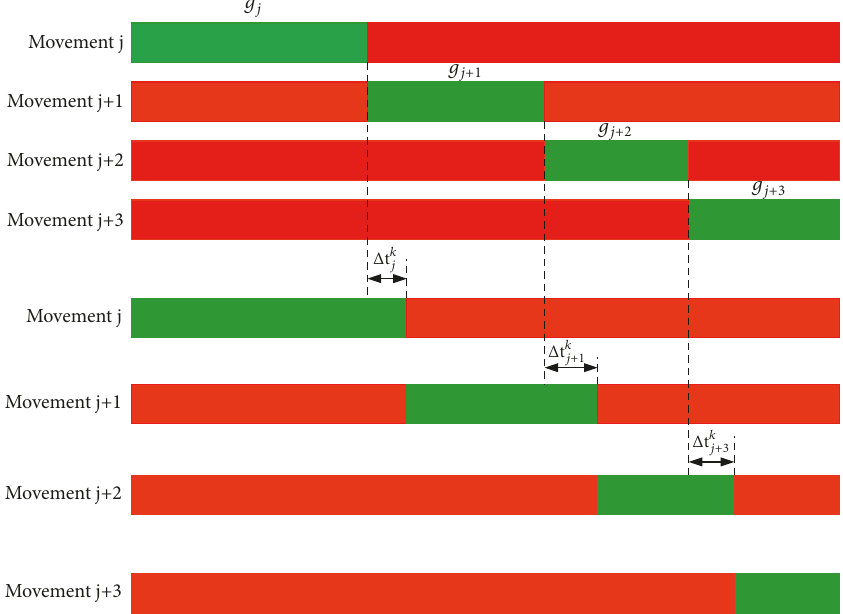
Figure 1: Illustration of the green extension